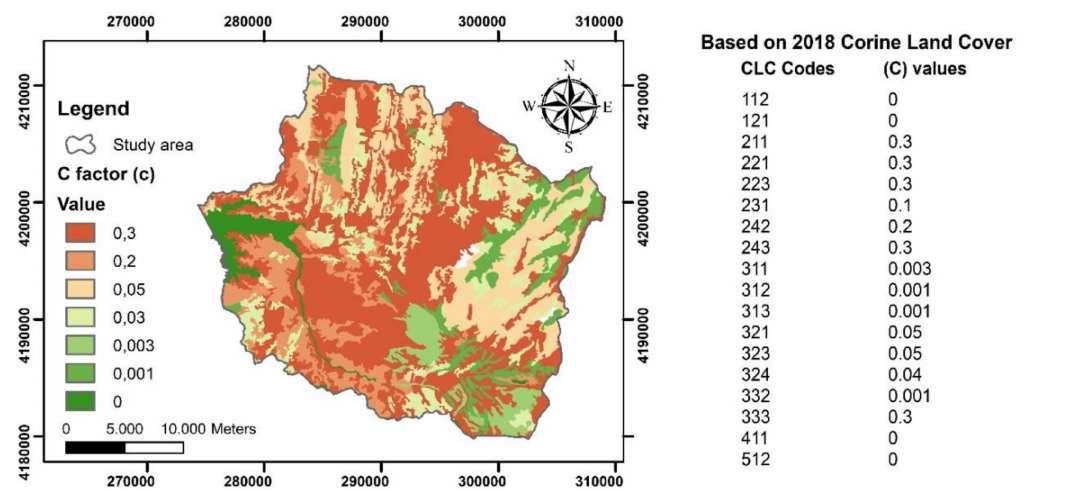
Figure 12. Cover management factor maps of the pilot area ( a ) before the wildfire, ( b ) after the wildfire and ( c ) a decade after the